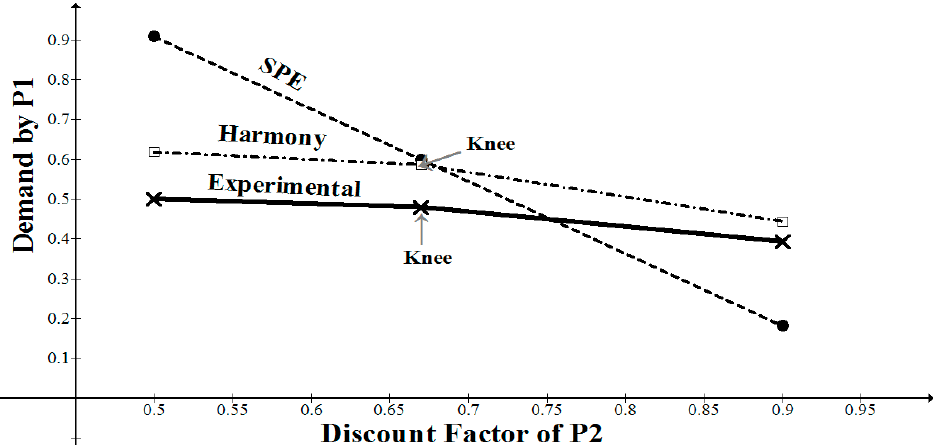
Figure 2. Experimental and theoretical opening demands by Player 1 for the Weg et al. (1990) study, as functions of the discount factor of Player